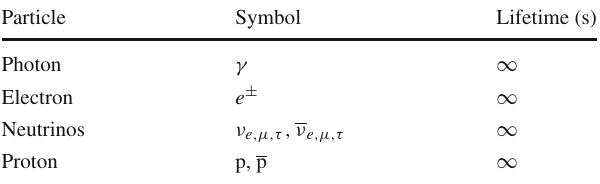
Table 4 Stable particles, relevant for evaporating BH in the present Universe and used to compute the hadronization table in pythia_tables_new/